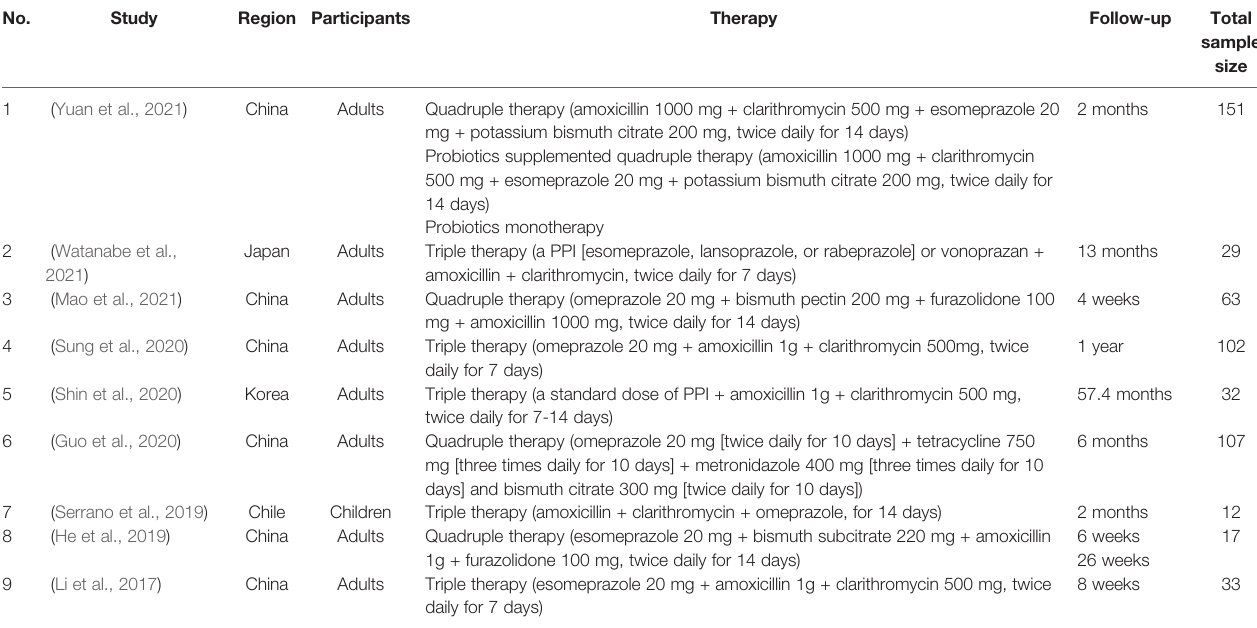
TABLE 1 | Characteristics of the included